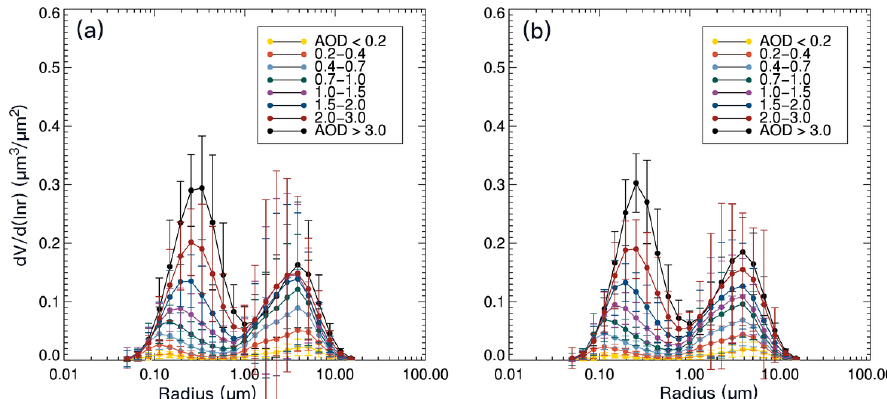
Figure 5. Size distribution as a function of AERONET AOD at 0.675µm, generated from the AERONET inversion products at cluster 1 illustrated in Fig. 3 using all available data records. Panel (a) is from April to September, panel (b) is from October to March. The error bars represent the standard deviation within each size